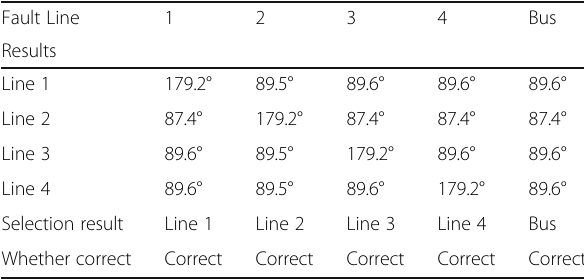
Table 2 Simulation results under